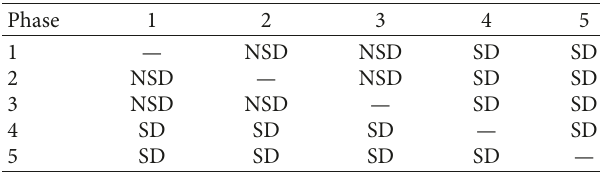
Table 4: The phase-specific significant difference in cases where a significant difference is found ( p < 0 . 001 in all instances where there was a statistically significant